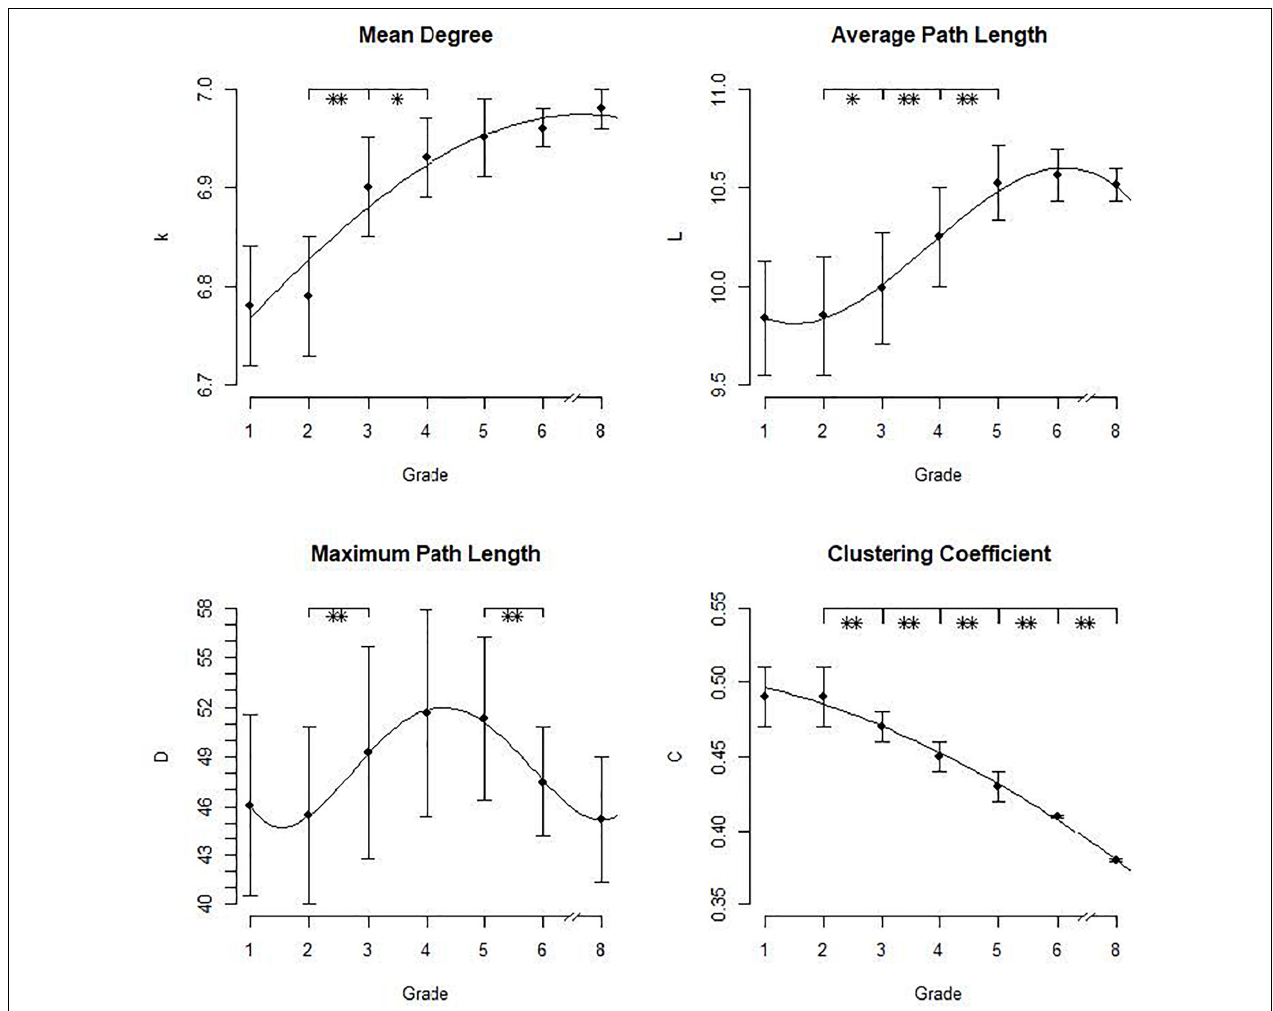
FIGURE 2 | Means and standard deviations for the network measures in the different grades with overall effects depicted as lines. ∗ p < 0.05, ∗∗ p < 0.01.